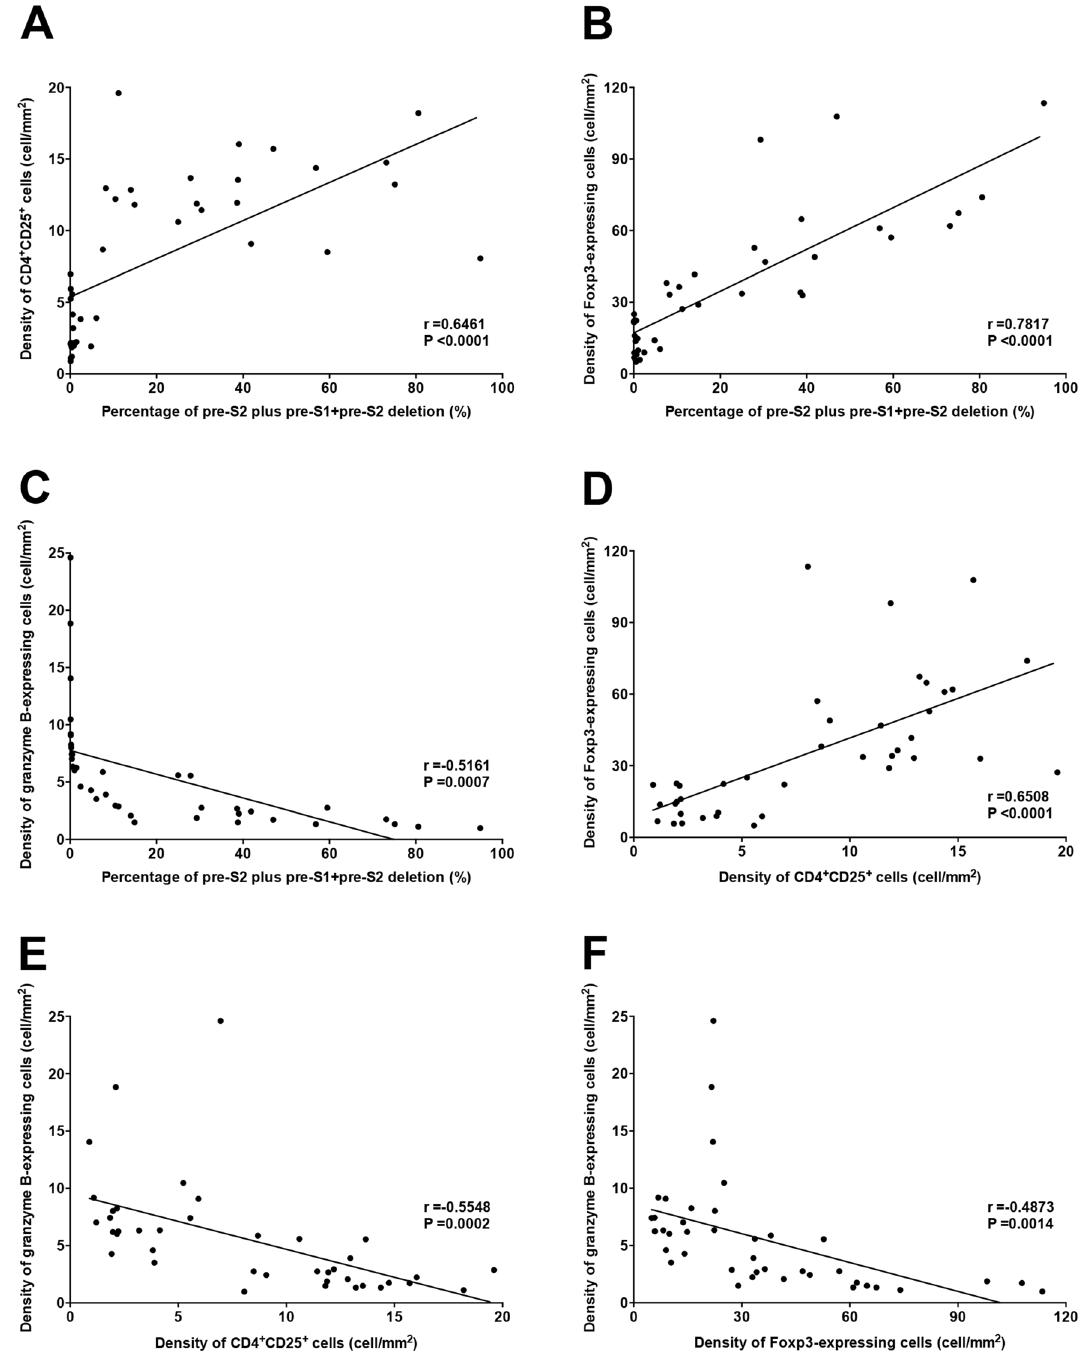
Figure 5. Percentage of pre-S2 plus pre-S1 + pre-S2 deletion was positively correlated with the density of CD4 + CD25 + cells and Foxp3-expressing cells but negatively with granzyme B-expressing cells in HCC tissues. ( A ) Correlation between the percentage of pre-S2 plus pre-S1 + pre-S2 deletion and the density of CD4 + CD25 + cells in HCC tissues. ( B ) Correlation between the percentage of pre-S2 plus pre-S1 + pre-S2 deletion and the density of Foxp3-expressing cells in HCC tissues. ( C ) Correlation between the percentage of pre-S2 plus pre- S1 + pre-S2 deletion and the density of granzyme B-expressing cells in HCC tissues. ( D ) Correlation between the density of CD4 + CD25 + cells and Foxp3-expressing cells in HCC tissues. ( E ) Correlation between the density of CD4 + CD25 + cells and granzyme B-expressing cells in HCC tissues. ( F ) Correlation between the density of Foxp3- and granzyme B-expressing cells in HCC tissues. The associated linear regression line was depicted in 40 HBV-related HCC patients in each graph. A P value < 0.05 was considered statistically